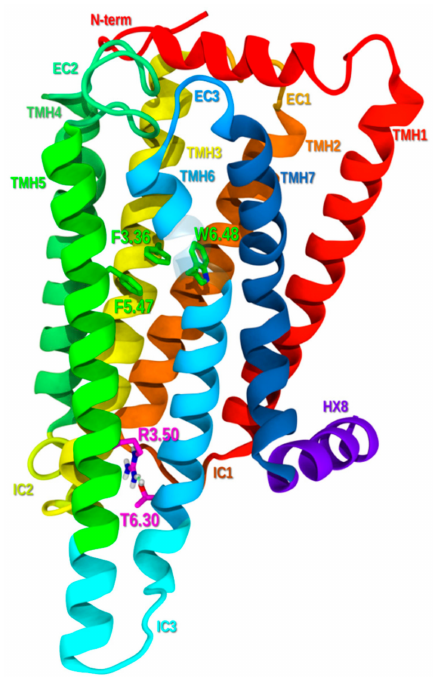
Figure 2. Lipid view of GPR6 from TMH5-TMH6 portal (portion of TMH6 made transparent for better view). Toggle switch residues (F3.36-W6.48-F5.47) are shown in green and ionic lock residues (R3.50-T6.30) are shown in